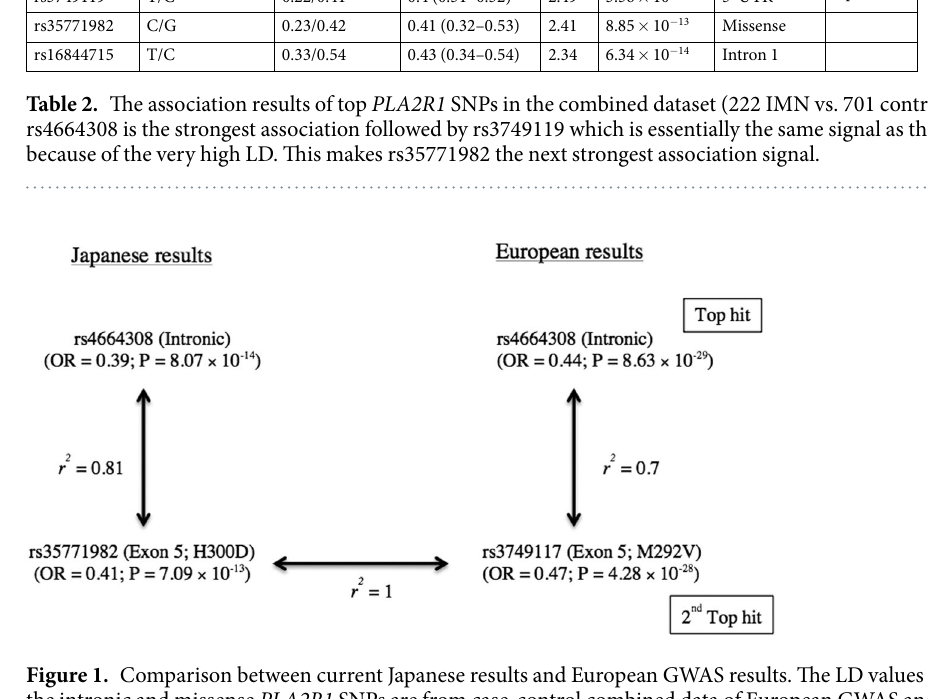
Figure 1. Comparison between current Japanese results and European GWAS results. The LD values between the intronic and missense PLA2R1 SNPs are from case-control combined data of European GWAS and the current study. The r 2 value between rs35771982 and rs3749117 is 1 for Asian and 0.98 for European (HaploReg database